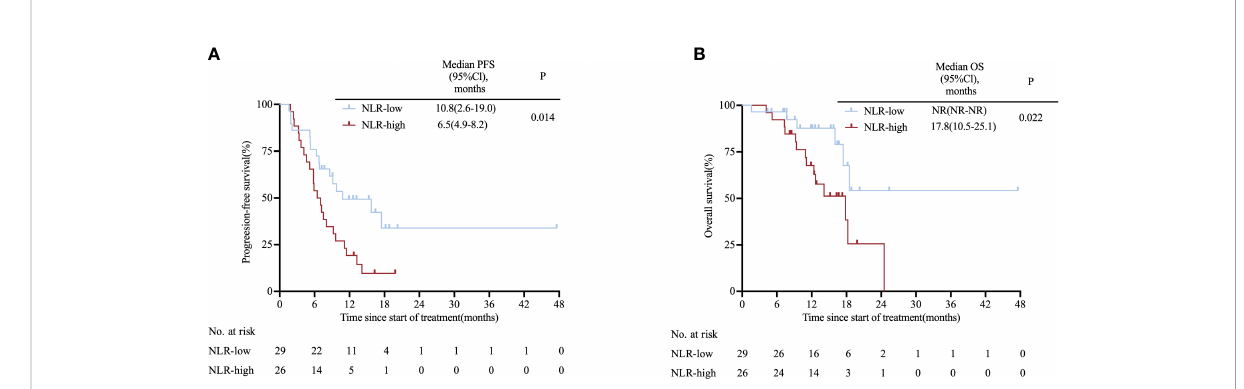
FIGURE 2 Kaplan-Meier survival curves in the real-world cohort strati fi ed by NLR for (A) PFS for NLR cut-off and (B) OS for NLR cut-off. CI , con fi dence interval ; NLR , neutrophil-to-lymphocyte ratio ; OS , overall survival ; PFS , progression-free